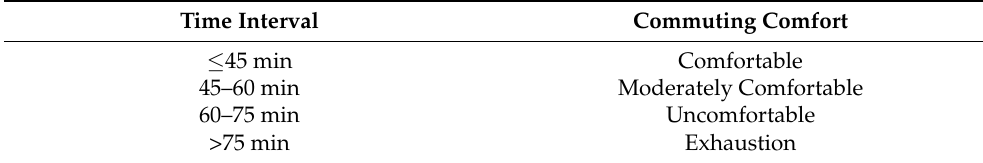
Table 8. Relationship between commute time and commuting comfort. Time